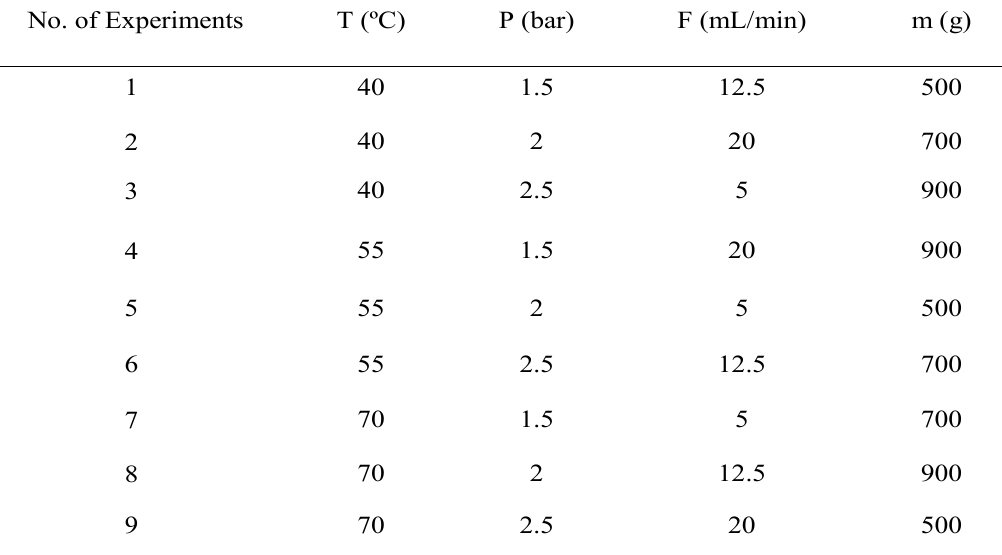
Experimental runs in the Taguchi’s L9(3 4 ) orthogonal array.